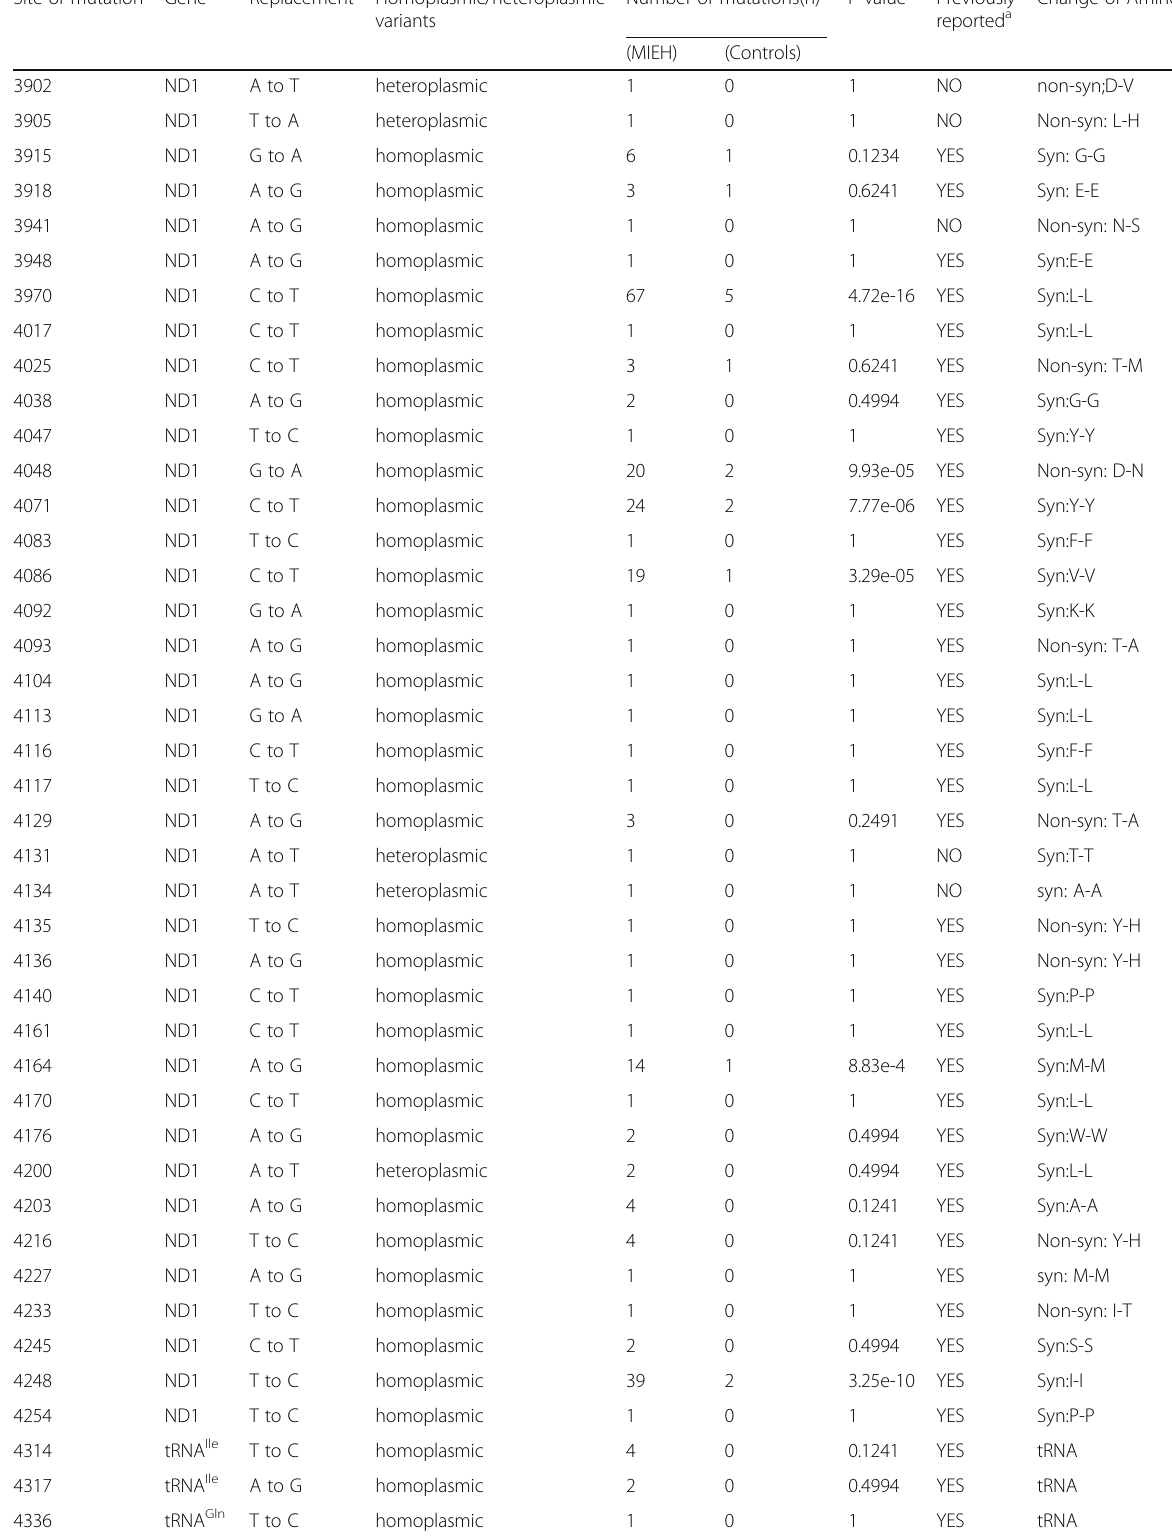
Table 3 Mutation sites of mtDNA in MIEH individuals and controls Site of mutation